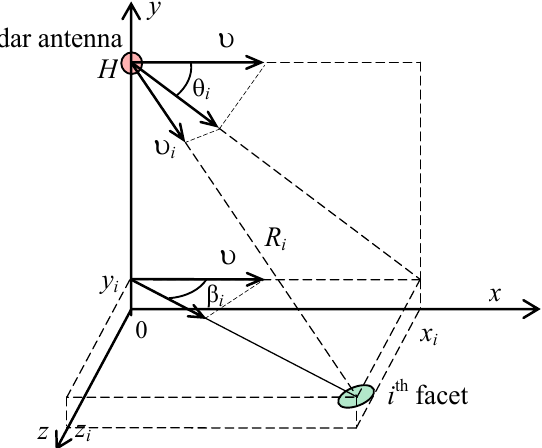
Fig. 2. Geometry of the relative positions of the radar antenna and the sample